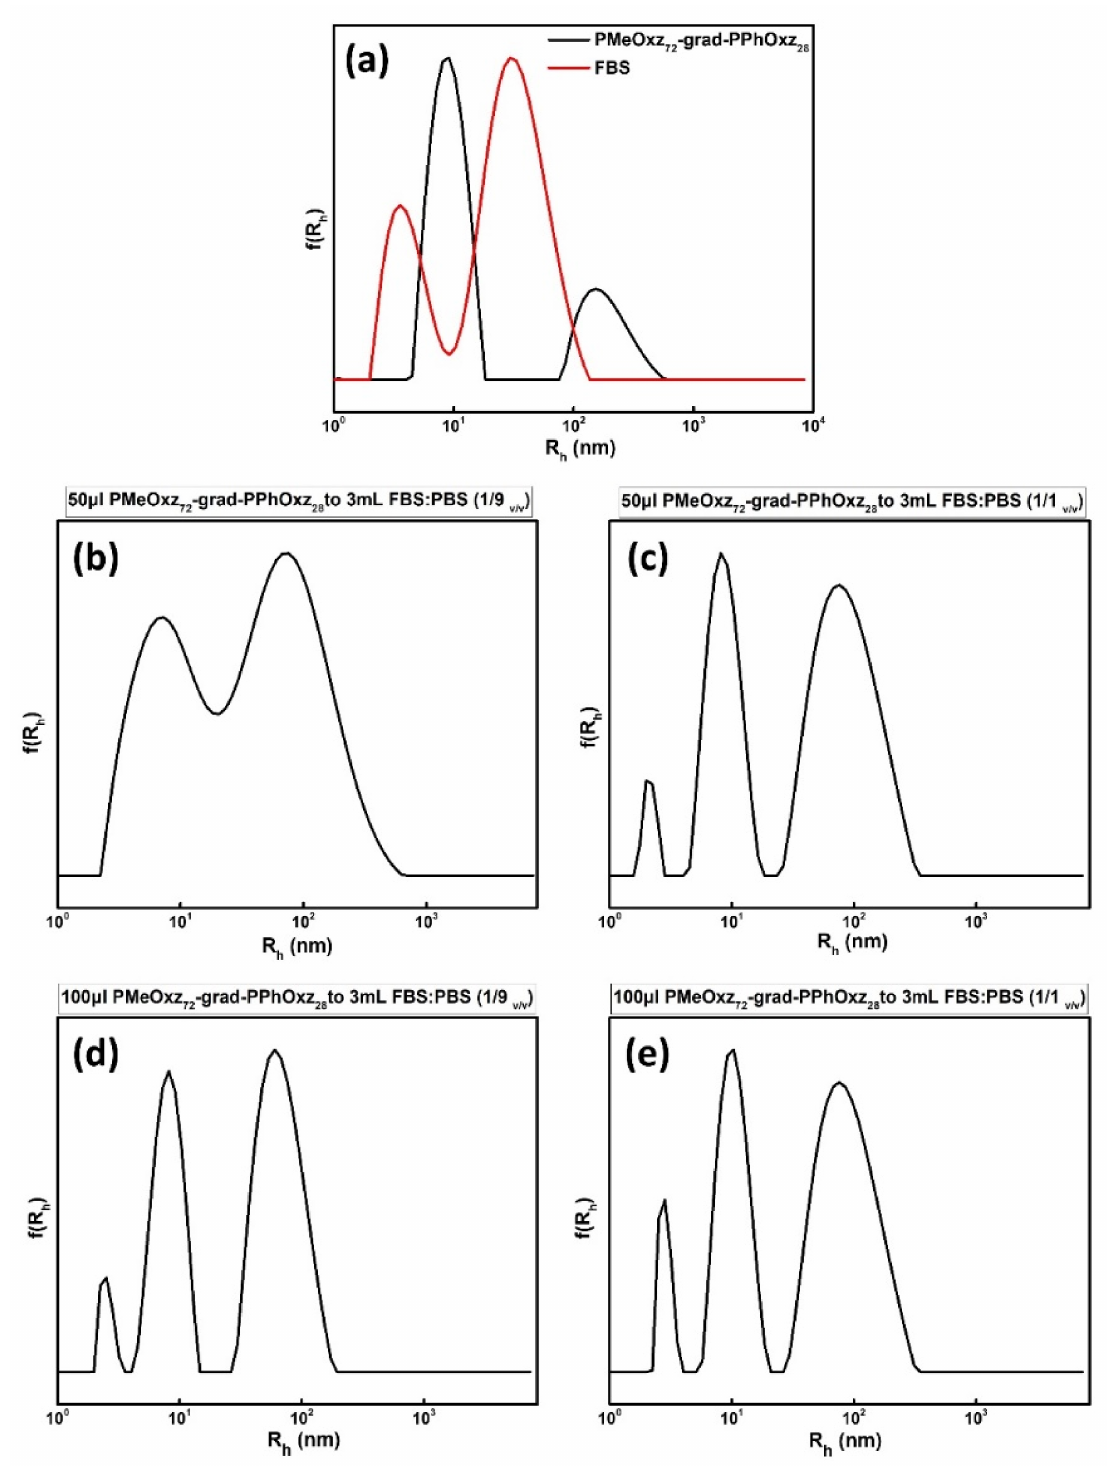
Figure 4. ( a ) Comparative size distributions of bare PMeOxz 72 -grad-PPhOxz 28 nanoassemblies in PBS and bare FBS and intensity size distributions of ( b ) PMeOxz 72 -grad-PPhOxz 28 + FBS:PBS (1/9 v/v) using protocol 1, ( c ) PMeOxz 72 -grad- PPhOxz 28 +FBS:PBS (1/1 v/v) using protocol 1, ( d ) PMeOxz 72 -grad-PPhOxz 28 + FBS:PBS (1/9 v/v) using protocol 2 and ( e ) PMeOxz 72 -grad-PPhOxz 28 + FBS:PBS (1/1 v/v) using protocol